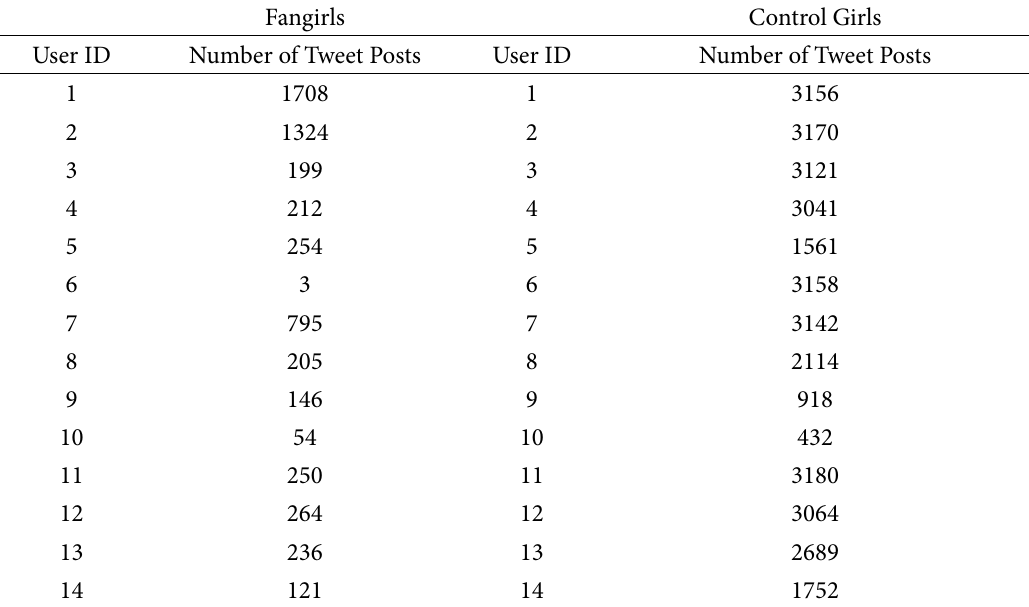
Table 2: Number of tweets collected from each user in Control and Fangirl datasets.